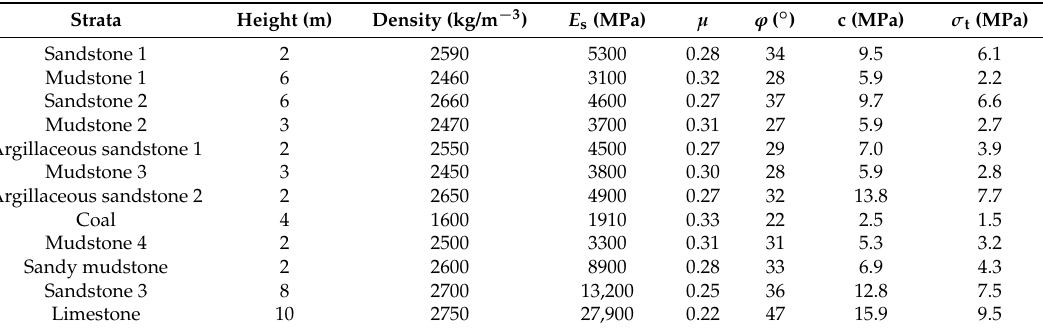
Table 7. Model parameters of the cemented rockfill with different granule